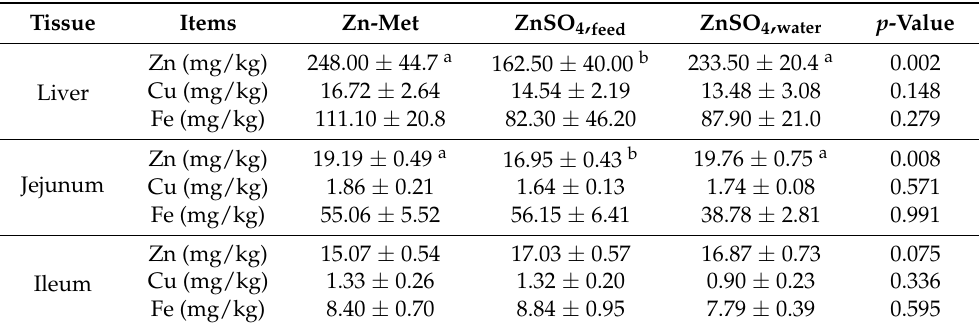
Table 4. Effect of different Zn supplementation forms on mineral concentrations in the jejunum, ileum, and liver of the